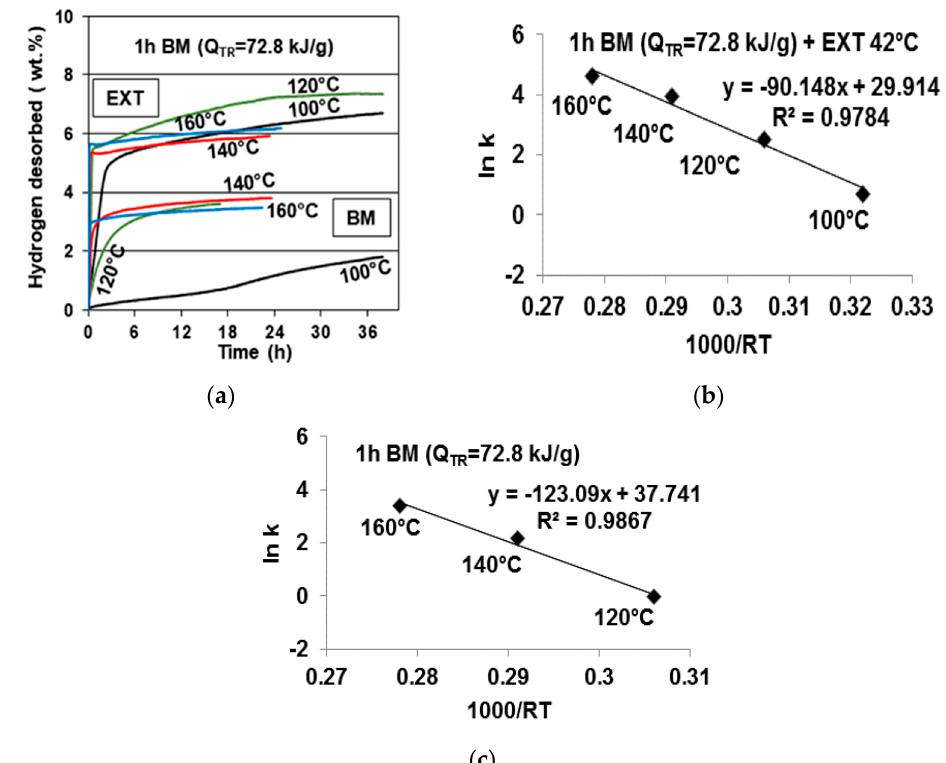
Figure 10. ( a ) H 2 desorption curves for a pre-milled and filtered/extracted (2NaBH 4 + MnCl 2 ) sample (EXT) as compared with the same ball 1 h (Q TR = 72.8 kJ/g) ball milled sample (BM). ( b ) The Arrhenius plot of rate constant k with temperature for the estimation of the apparent activation energy (AAE) of hydrogen desorption from the filtered/extracted sample. ( c ) The Arrhenius plot for the same sample just after 1 h BM [11].